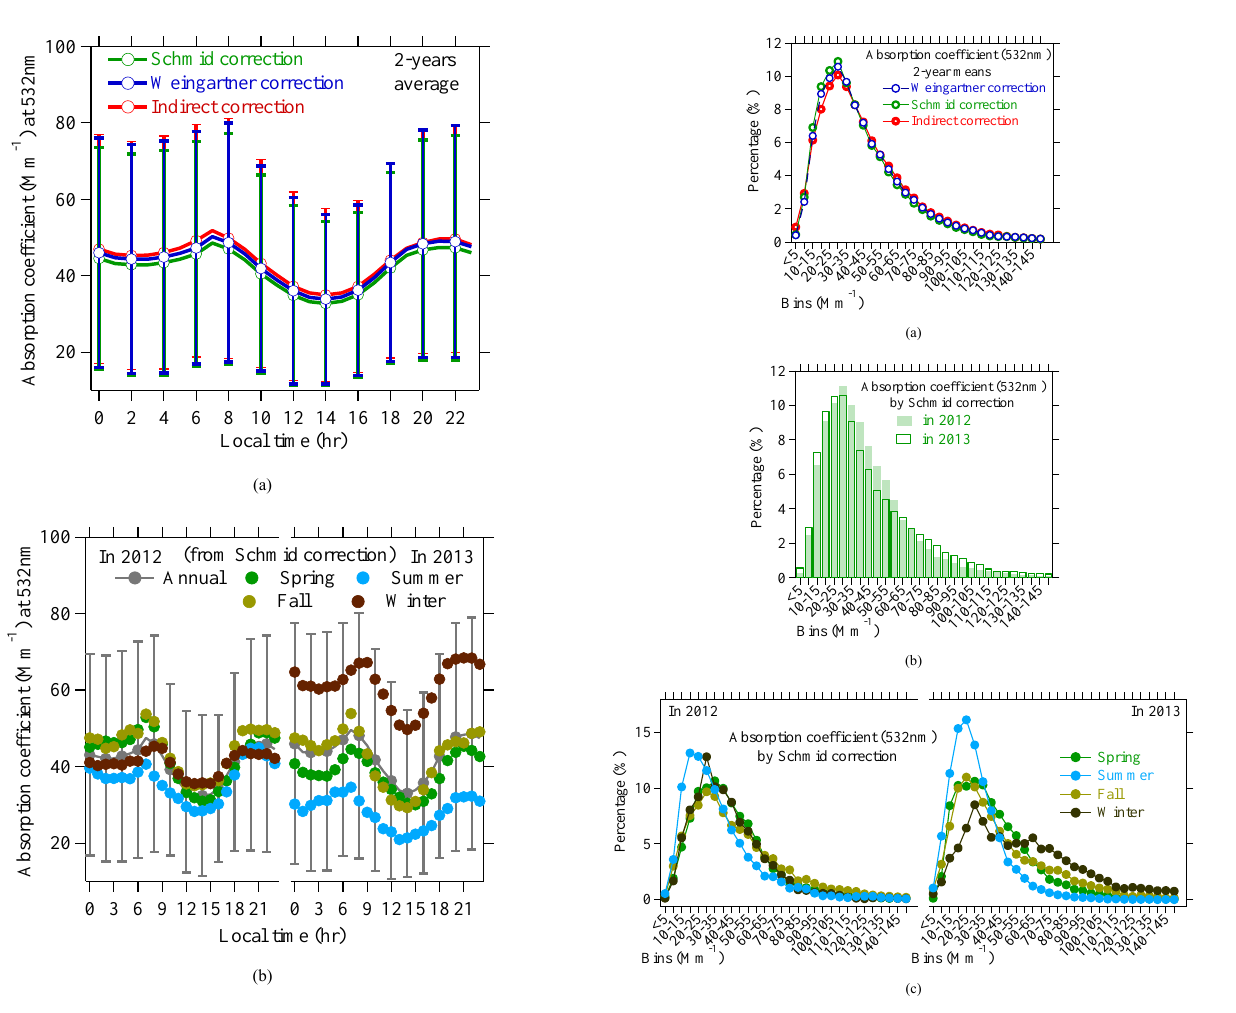
Figure 5 725 Figure 5. Frequency distributions of the aerosol absorption coeffi- cients at 532nm in the urban area of Nanjing. (a) the 2-year (2012– 2013) coefficients corrected by IDC (red), WC2003 (blue), and SC2006 (light green). Panel (b) shows the coefficients corrected by SC2006 in the separate years of 2012 (solid bar) and 2013 (blank bar), and panel (c) shows the coefficients corrected by SC2006 in separate seasons of separate years. frequency of 532 nm AAC only to avoid duplication. Fig- ure 5a shows the frequency distributions of 532 nm AAC corrected by IDC, WC2003, and SC2006 during the study period, following a typical log-normal pattern. The range from 15 to 65 Mm − 1 dominated, accounting for more than 72 % of the total data samples during the period. The max- imum frequencies of 10.07 % (IDC), 10.57 % (WC2003), and 10.89 % (SC2006) occurred in the ranges from 25 to 30 Mm − 1 . The absolute differences between the directly and indirectly corrected AACs were relatively larger in the range from 20 to 25 Mm − 1 than those in other ranges, possibly due to the influence of the shadowing effect in warming sea- sons as analyzed in Sect. 3.1. Because of the